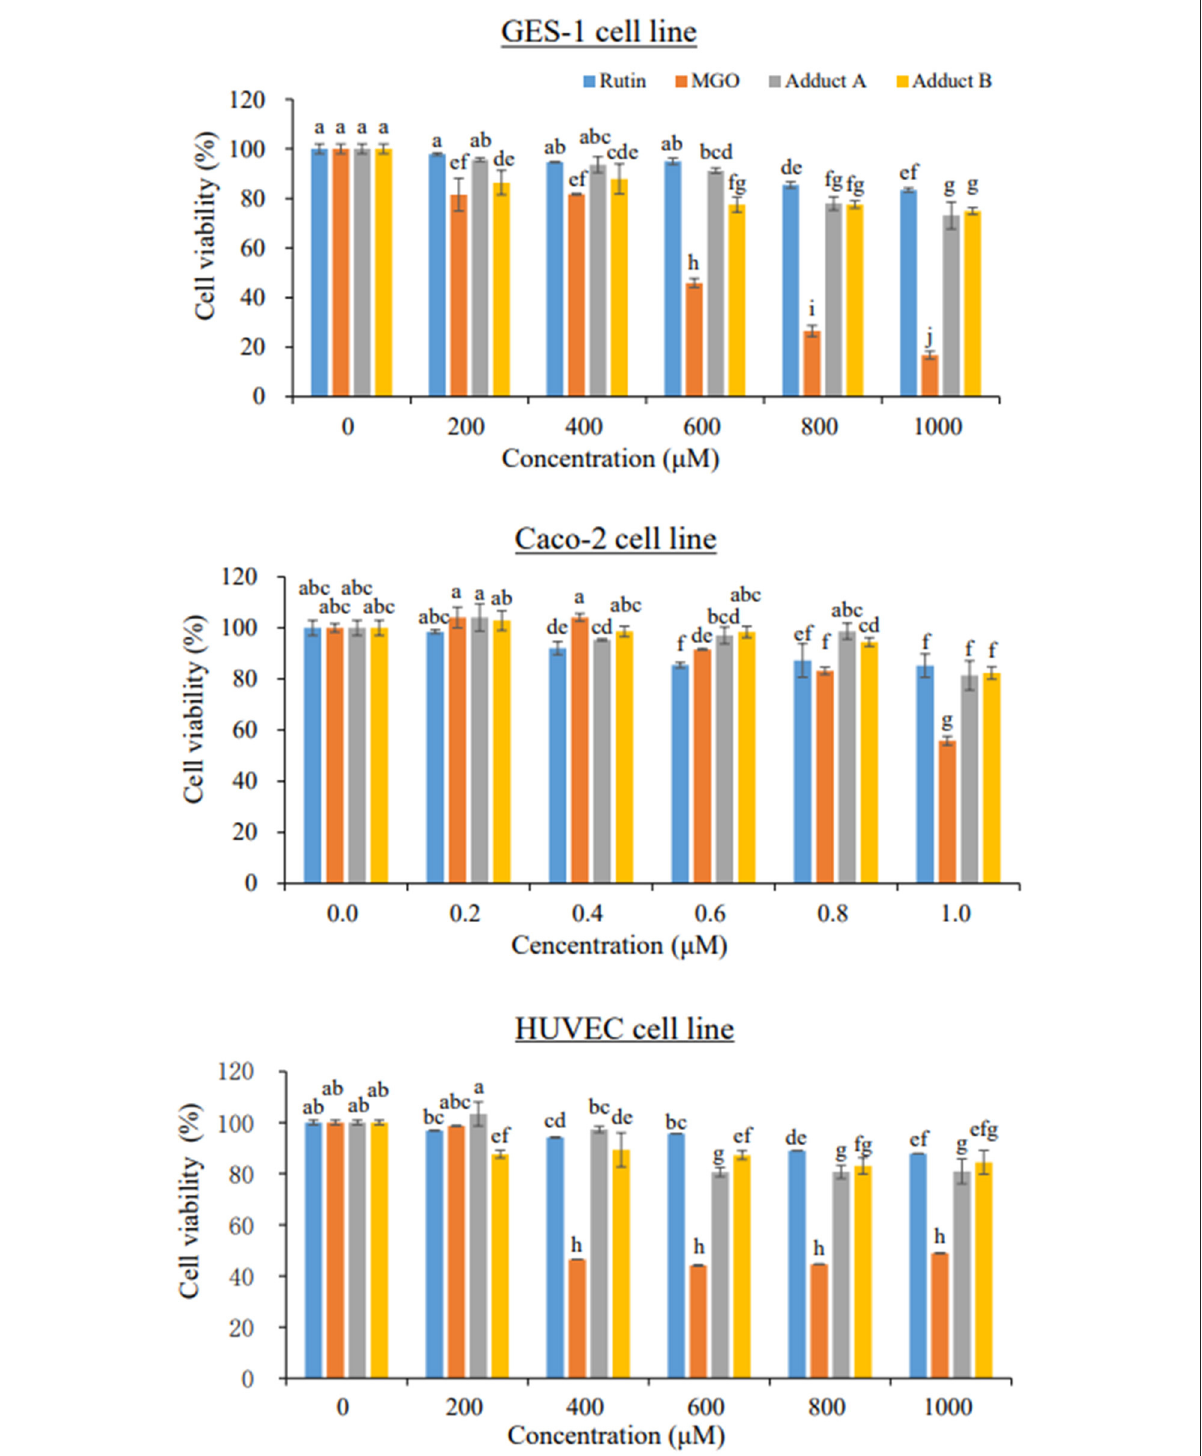
FIGURE3 Cell viability of GES-1 (upper), Caco-2 (middle), and HUVEC cells (bottom) under 24 h treatments by different concentrations of rutin, MGO, adduct A, and adduct B. Different letters represent significant differences ( P <